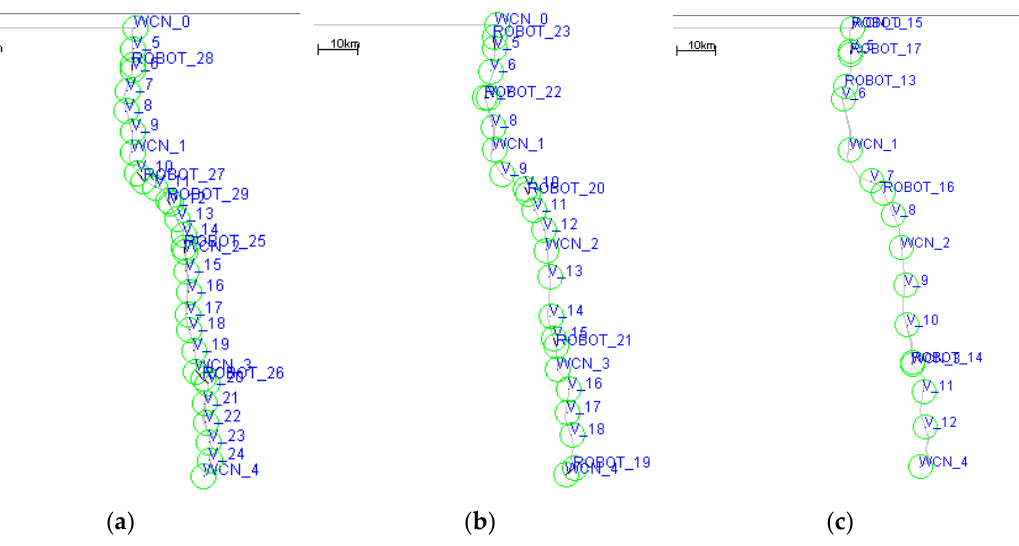
Figure 4. Nodes deployment diagram with different ρ . ( a ) ρ = 0.9; ( b ) ρ = 0.5; ( c ) ρ = 0.3.